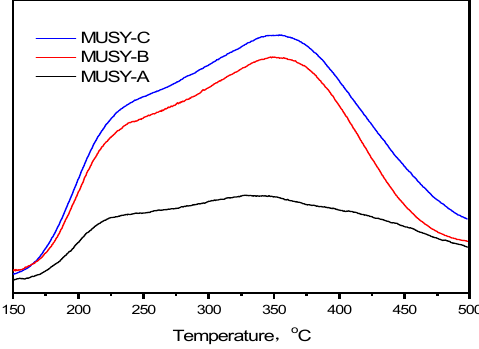
Figure 5. NH 3 -TPD properties of the zeolite samples.